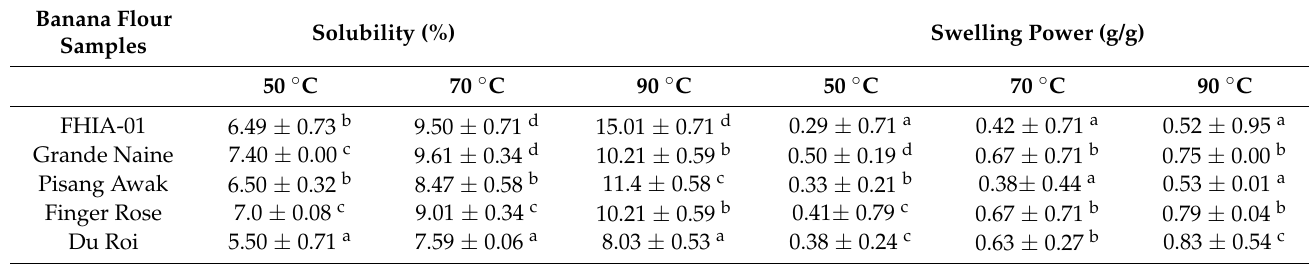
Table 4. The water solubility and swelling index of banana flour (d.w.).